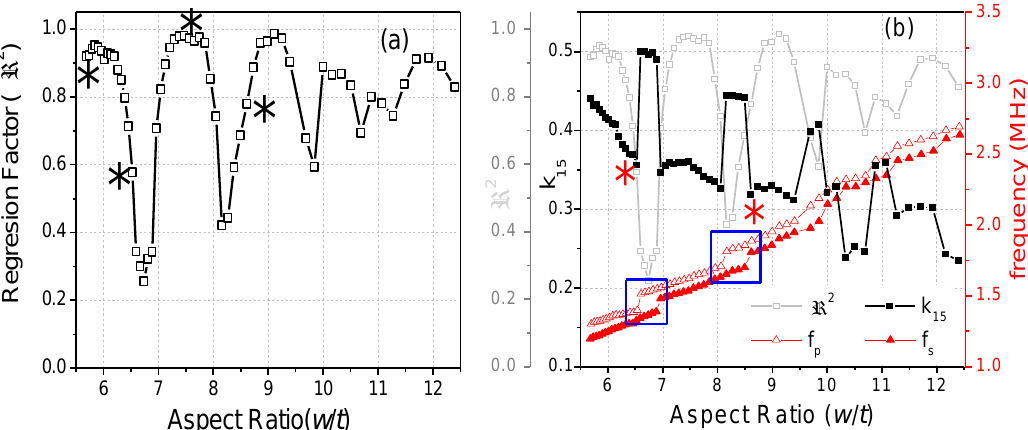
Figure 3. Evolution as a function of the aspect ratio of the BCZT plate: ( a ) of the reconstructed to the experimental resonance spectra regression factor, R 2 , (the points marked with (*) correspond to the spectra of Figure 2, which are examples of uncoupled shear modes with high R 2 , and Figure 4, examples of coupled modes with low R 2 ) and ( b ) of the frequencies fp and fs and the electromechanical coupling factor, k 15 ; squares indicate anomalies in the difference ( fp - fs ).